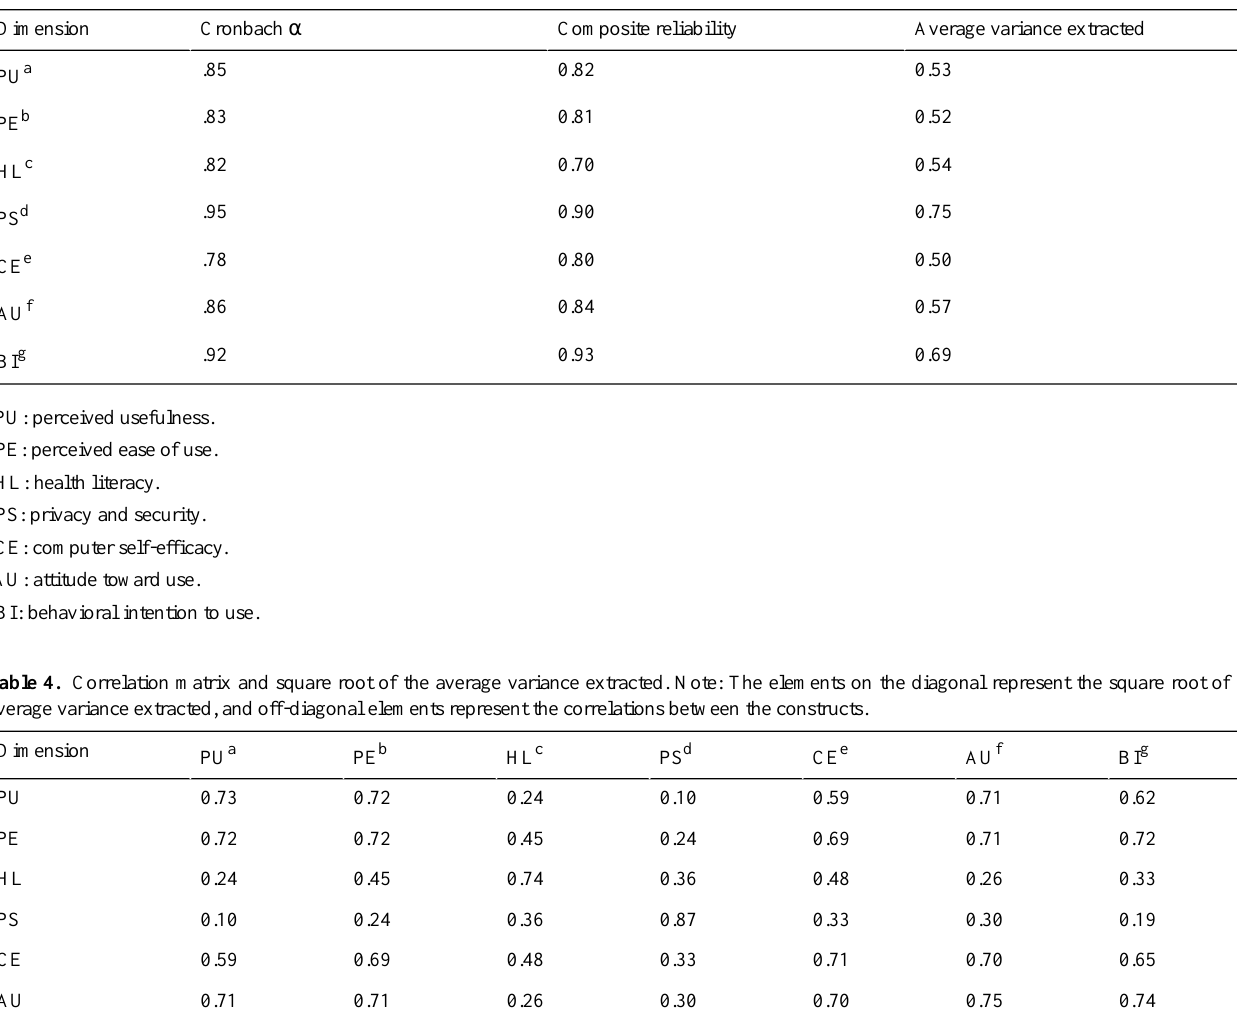
Table 3. Cronbach alpha, composite reliability, and average variance extracted.